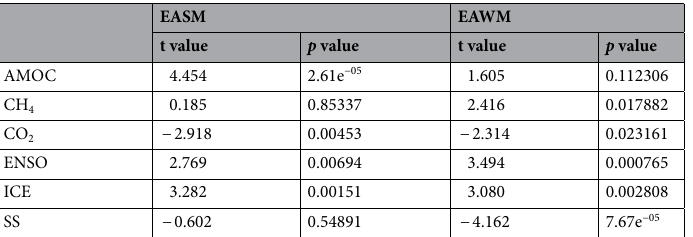
Table 1. Linear model simulation of East Asian summer monsoon (EASM; Table S1) and winter monsoon (EAWM; Table S2) versus selected driving mechanisms (Table S3). The t value is the regression coefficient divided by its standard error. The size of the t-value for each mechanism is a measure of the effect that mechanism is having on EASM or EAWM variability, and its (positive or negative) sign provides the direction of the effect. The p value denotes the significance level for the relationship between the mechanisms, and EASM as well as EAWM variability. See “Material and methods” section for detail description the linear regression